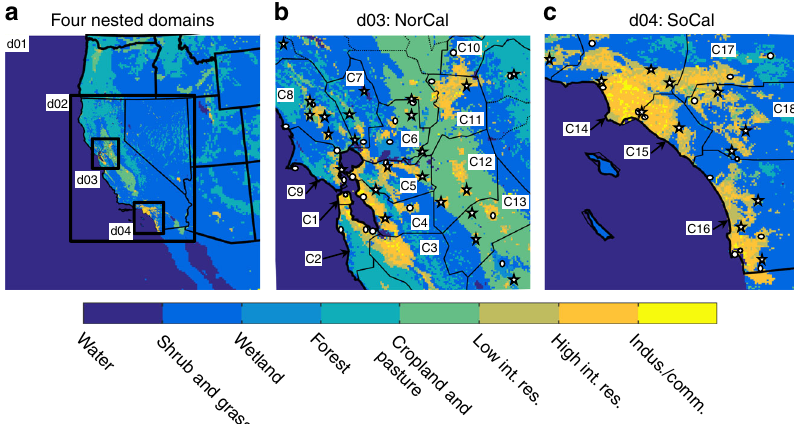
Fig. 1 Land cover map and geographical representation of study domains. a Nested con fi guration of four WRF-UCM domains with 13.5, 4.5, 1.5, and 1.5 km spatial resolutions for d01, d02, d03, and d04, respectively. b Domain d03. c Domain d04. The solid black lines in b , c illustrate the boundaries of the 18 urban counties that are captured in domains d03 and d04: San Francisco (C1), San Mateo (C2), Santa Clara (C3), Alameda (C4), Contra Costa (C5), Solano (C6), Napa (C7), Sonoma (C8), Marin (C9), Placer (C10), Sacramento (C11), San Joaquin (C12), Stanislaus (C13), Los Angeles (C14), Orange (C15), San Diego (C16), San Bernardino (C17), and Riverside (C18). The location of NCDC and CIMIS stations, used in validation process, are indicated with circles and stars, respectively. Note that urban areas are represented through three land cover types: low intensity residential (Low int. res.), high intensity residential (High int. res.), and industrial/commercial